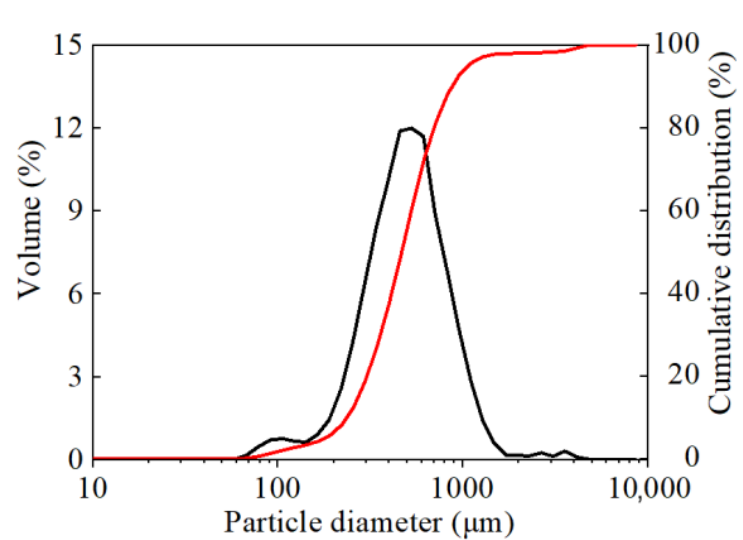
Figure 10. Features of PS area and PS.